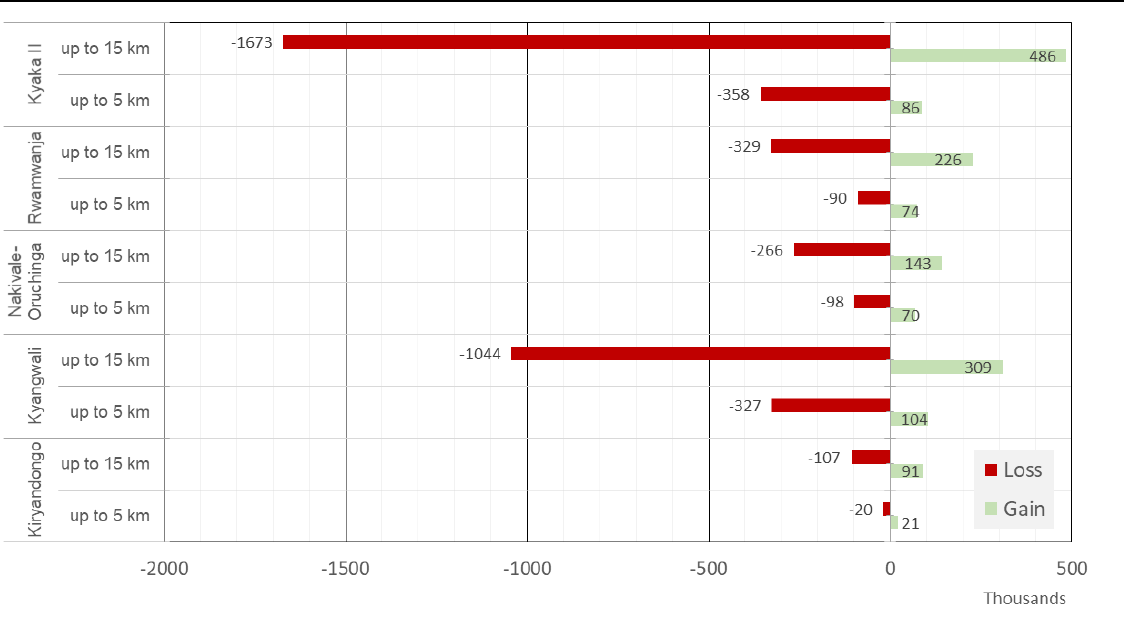
Figure 9. Summary of AGB stock changes across the AoIs (2000 – 2017) in western and southwestern Uganda. Source: World Bank and FAO, 2020b [30]. Note: Loss/gain is associated with LULC changes. For example, if there was a change from higher stock LULC to lower stock LULC, then there was a loss of biomass, and vice versa. Both of these transitions were found in all buffer zones, and respective loss/gain was estimated accordingly.